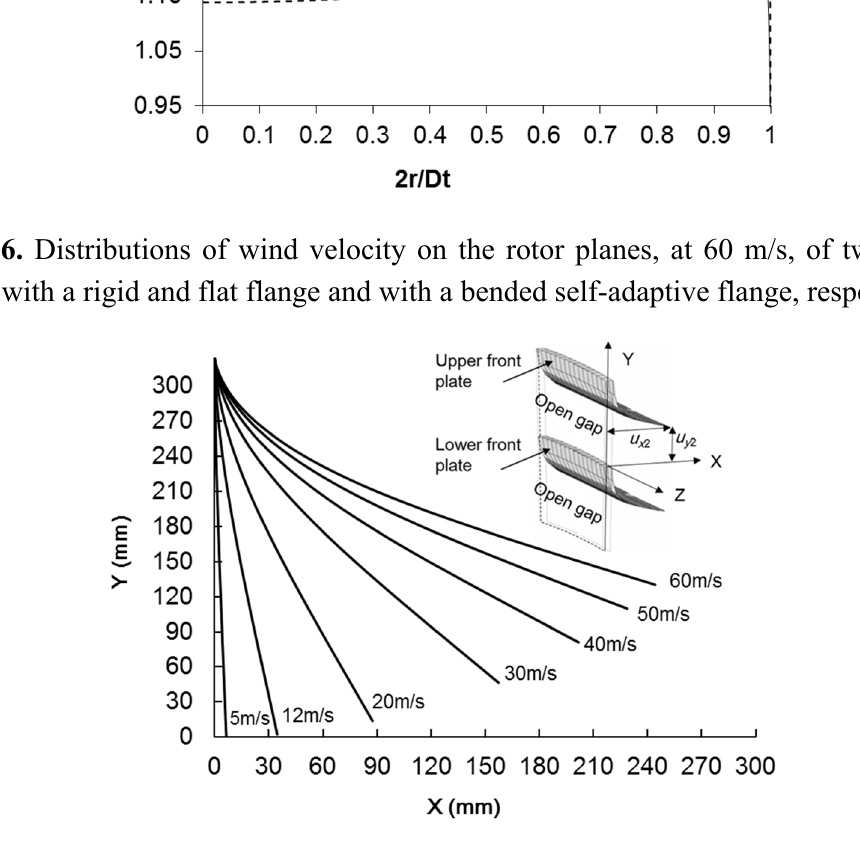
Figure 17. Configurations of deformed upper front plate of the self-adaptive flange at various wind velocities.